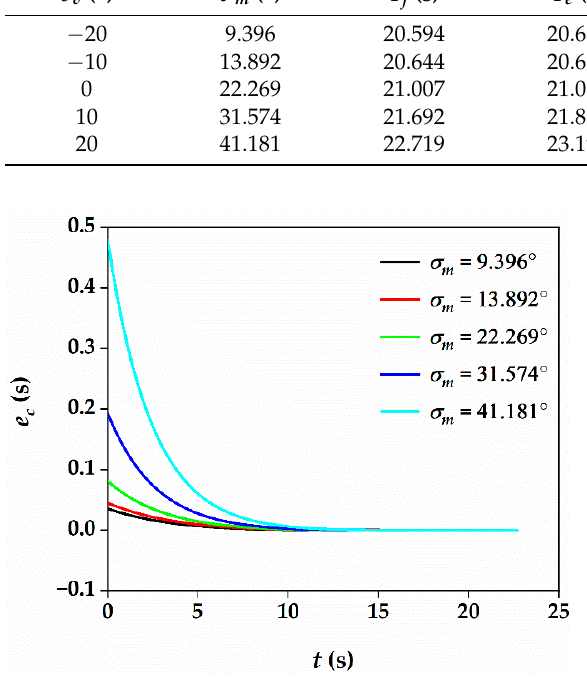
Figure 3. Simulation results under different initial lead angles.